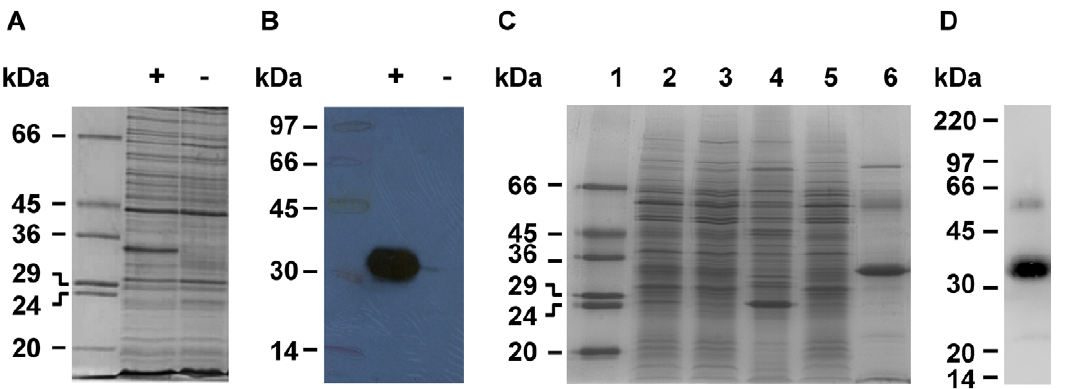
Figure 5. Expression and purification of BC4707-RGSHis 6 . Protein expression was induced for 3 hours by addition of IPTG (1 mM) to exponentially growing bacteria. Cells were harvested and mixed membrane preparations were made from each culture. The proteins in the mixed membrane fractions prepared by the water-lysis technique [47] were separated by SDS-PAGE and detected by: (A) Coomassie Blue stain; or (B) Western blotting with an antibody to the RGSHis 6 -tag ( + and 2 represent mixed membrane preparations of induced and uninduced cells, respectively). Purification of BC4707-RGSHis 6 was done by immobilized metal affinity chromatography (IMAC). Staining with Coomassie Blue (C) shows the enrichment and purity of BC4707-RGSHis 6 at different stages of purification. The gel was loaded as follows: 1) molecular weight marker 2) inner membranes solubilized in dodecyl-beta-D-maltoside detergent; 3) supernatant of the solubilized inner membranes after ultracentrifugation; 4) pellet of the solubilized inner membrane fraction after ultracentrifugation; 5) flow-through after IMAC-binding; 6) elution fraction (5 m g protein).